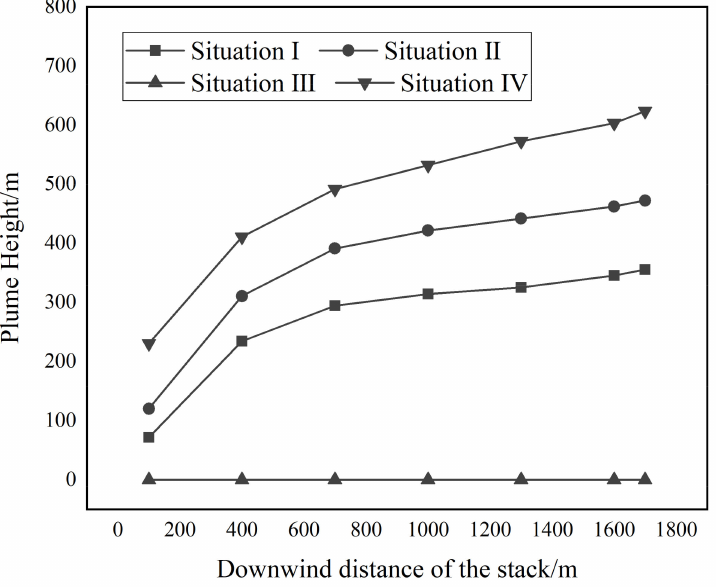
Figure 9. BL3 Simulations: different exhaust plume heights in different